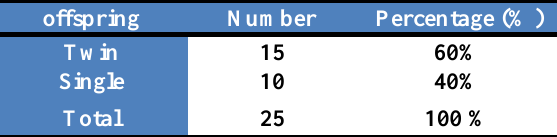
Table, 2: Distribution of parturition of pregnant animal according to offspring in